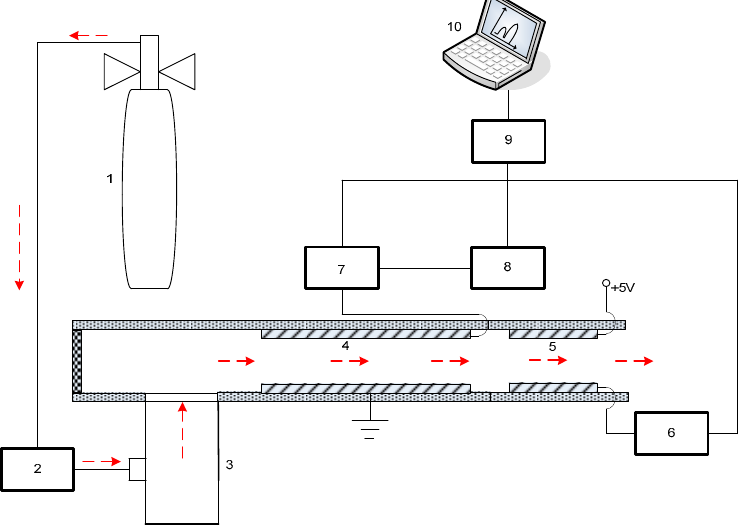
Figure 9. Schematic diagram of the high-field asymmetric ion mobility spectrometry (FAIMS) setup. 1. Sample gas; 2. Flow meter; 3. Microelectromechanical systems (MEMS) chip; 4. Drift region; 5. Detector; 6. Electrometer; 7. The high-filed rectangular asymmetric waveform; 8. The compensation voltage; 9. Controller; and 10. Computer.